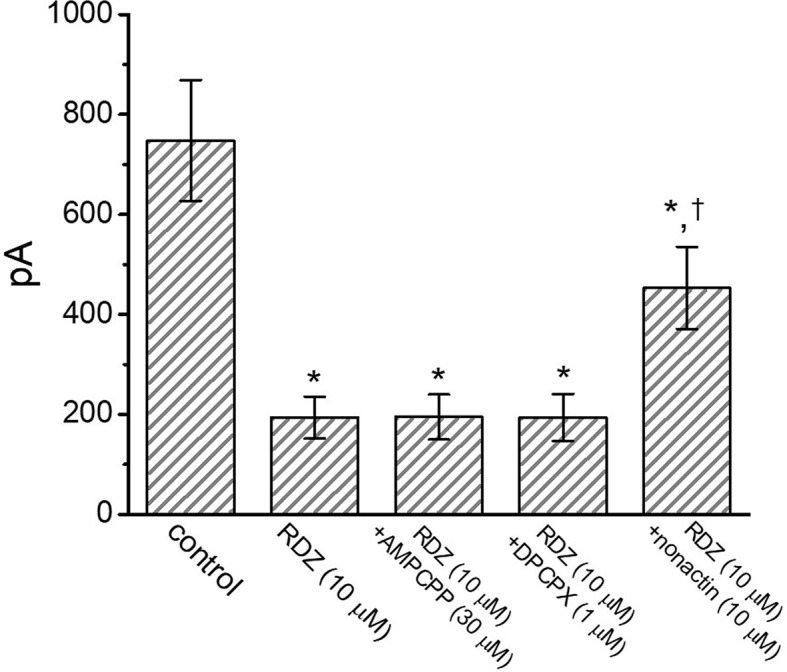
Comparisons among the effect of RDV, RDV plus α,β-methylene ATP (AMPCPP), RDV plus cyclopentyl-1,3-dipropylxanthine (DPCPX) and RDV plus nonactin on I
K(DR) amplitude in GH3 cells (mean ± SEM; n=8 for each bar). GH3 cells were bathed in Ca2+-free, Tyrode’s solution and the electrode was filled with K+-containing internal solution. Current amplitude from −50 mV depolarizing pulse to +50 mV depolarization with a duration of 1 sec was measured at the end of depolarizing command potential. In this set of experiments on RDZ plus each agent, the tested compound was subsequently added in the continued presence of RDV (10 μM). *Significantly different from control (P<0.05).